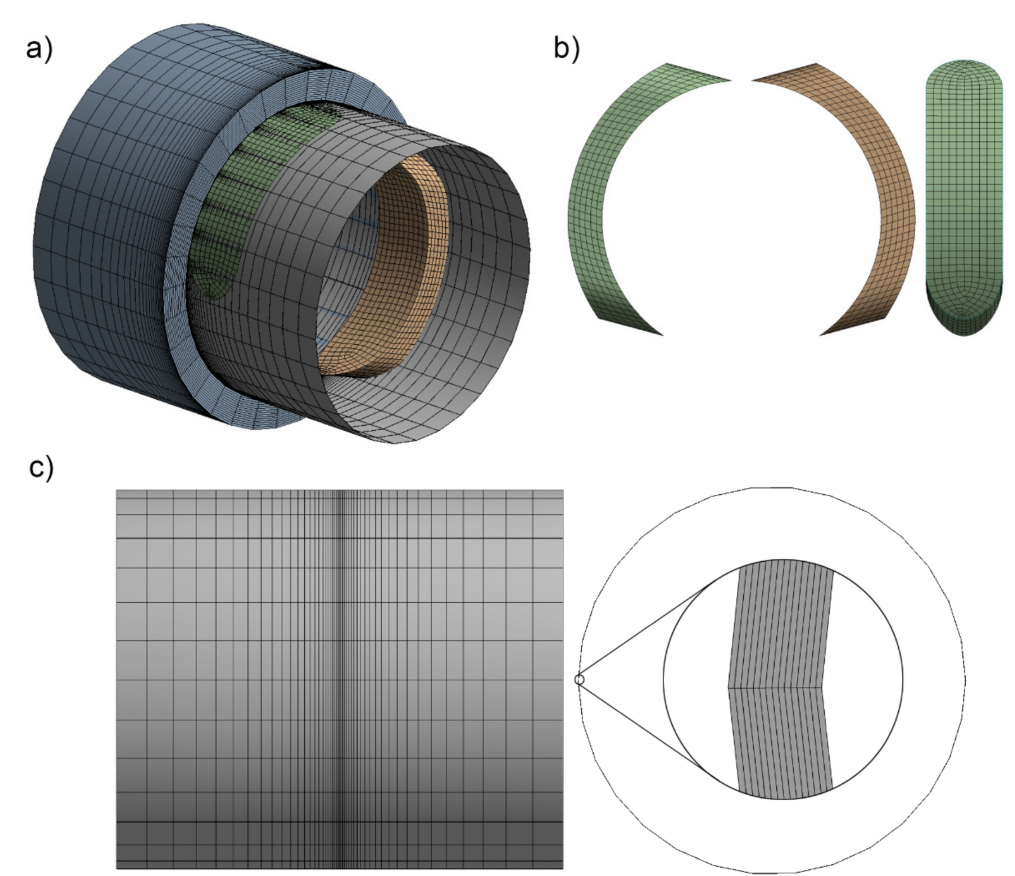
Figure 21. Discretization of the domain into computational mesh: ( a ) complete model; ( b ) commutation windows; ( c ) gap between the commutation tube and socket [26].